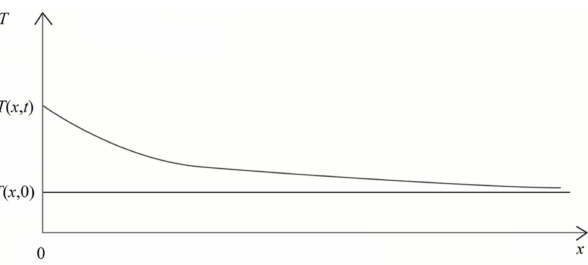
Figure 2. Spatial variation diagram of the temperature field under the boundary condition of Newton’s law of